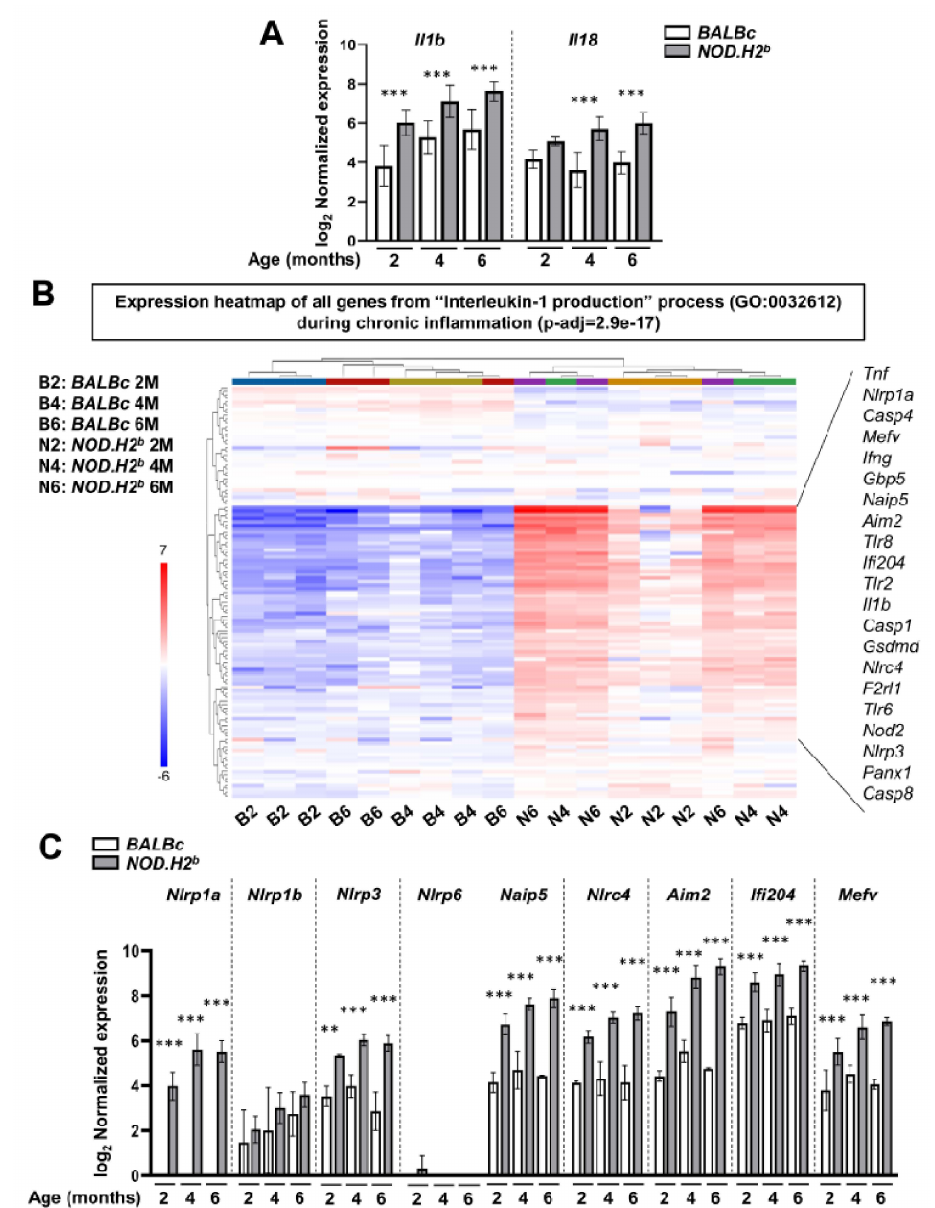
Figure 4. RNA-seq analysis of inflammasome pathway during chronic inflammation. ( A ) mRNA expression of Il1b and Il18 is increased in NOD.H2 b LGs (grey) compared to BALBc (white) at 2M, 4M, and 6M. ( B ) Expression heatmap of the genes involved in “interleukin-1 production” (GO:0032612) pathway in each biological replicate (1 sample = 1 LG) from BALBc (“B”) or NOD.H2 b (“N”) mice at 2, 4, or 6M. Individual LG sample cluster in two main groups; all NOD.H2 b samples show an important activation of genes involved in this pathway compared to BALBc . Selected genes that participate directly in inflammasome complexes/signaling or are upstream activators are shown in frame on the right. ( C ) mRNA expression of the different inflammasome sensors in NOD.H2 b LGs (grey) compared to BALBc (white) at 2M, 4M, and 6M. Error bars show the mean (SD). Significant differences are represented as ** if p < 0.01, and *** if p <